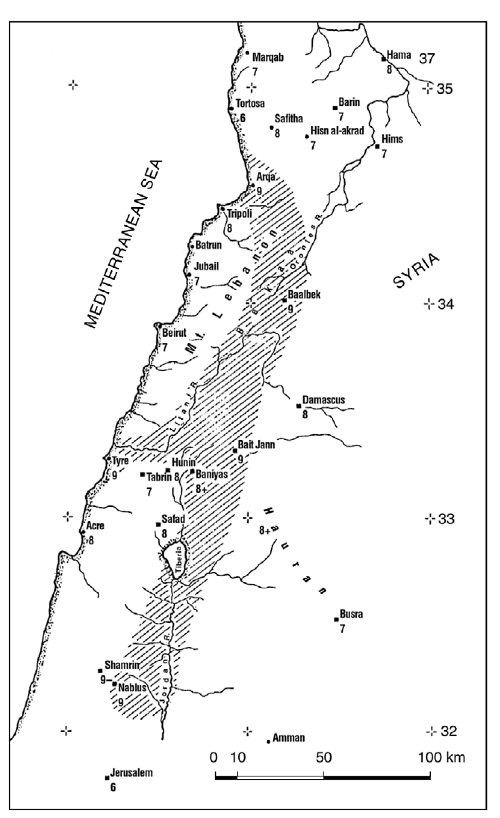
Fig. 16. Map of intensity distribution for May 20, 1202 earthquake (Ambraseys and Melville, 1985). Shaded zone is the most affected